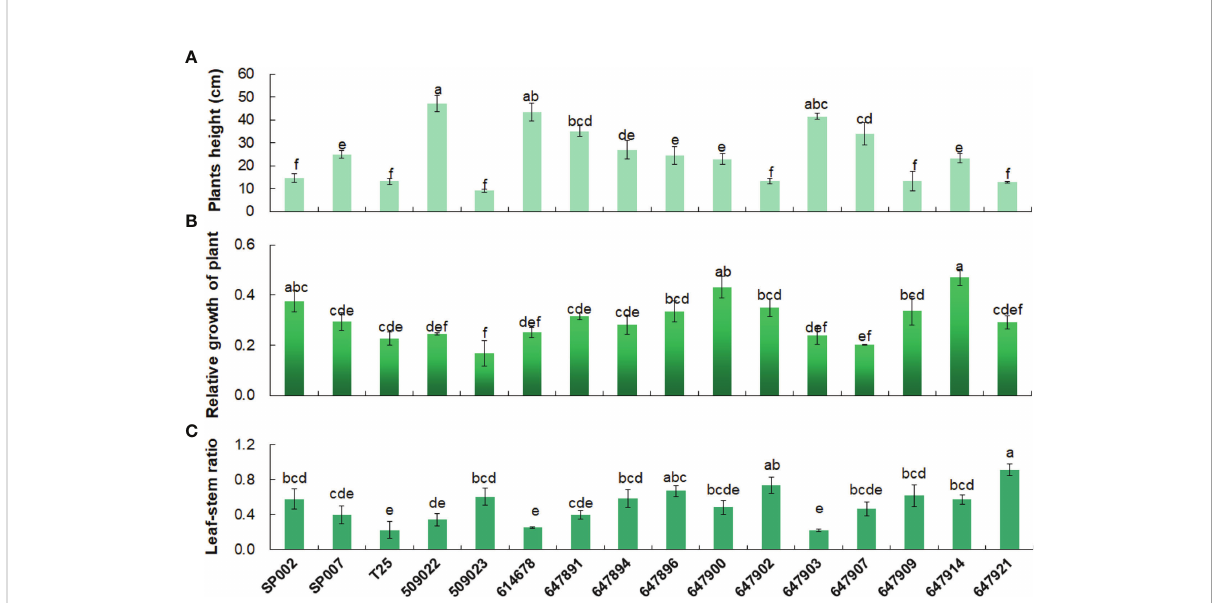
FIGURE 2 Agronomic traits analysis of 16 seashore paspalum ecotypes. Plants height (A) , Relative growth of plant (B) and Leaf – stem ratio (C) of 16 seashore paspalum ecotypes were measured when plants grown in the greenhouse for 8 weeks. Means of three replicates and standard errors are presented; the same letter above the column indicates no signi fi cant difference at P